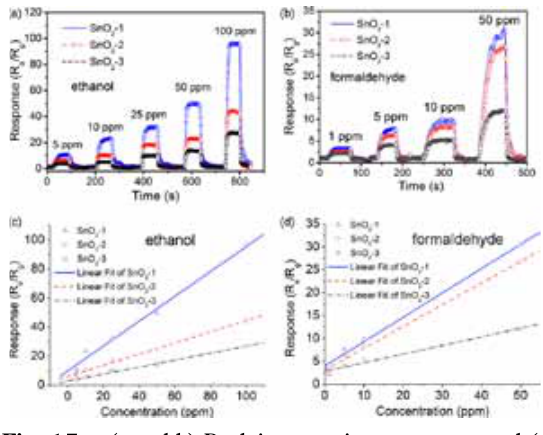
Fig. 15 (a and b) Real-time sensing responses and (c and d) response variations of the sensors to ethanol (170 ℃ ) and formaldehyde (210 ℃ ) of different concentrations,